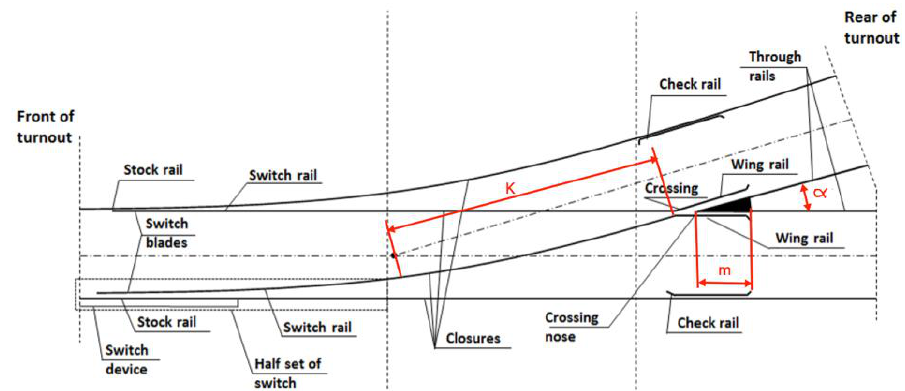
Figure 7. Turnout geometry and parameters. Table 3. Turnout